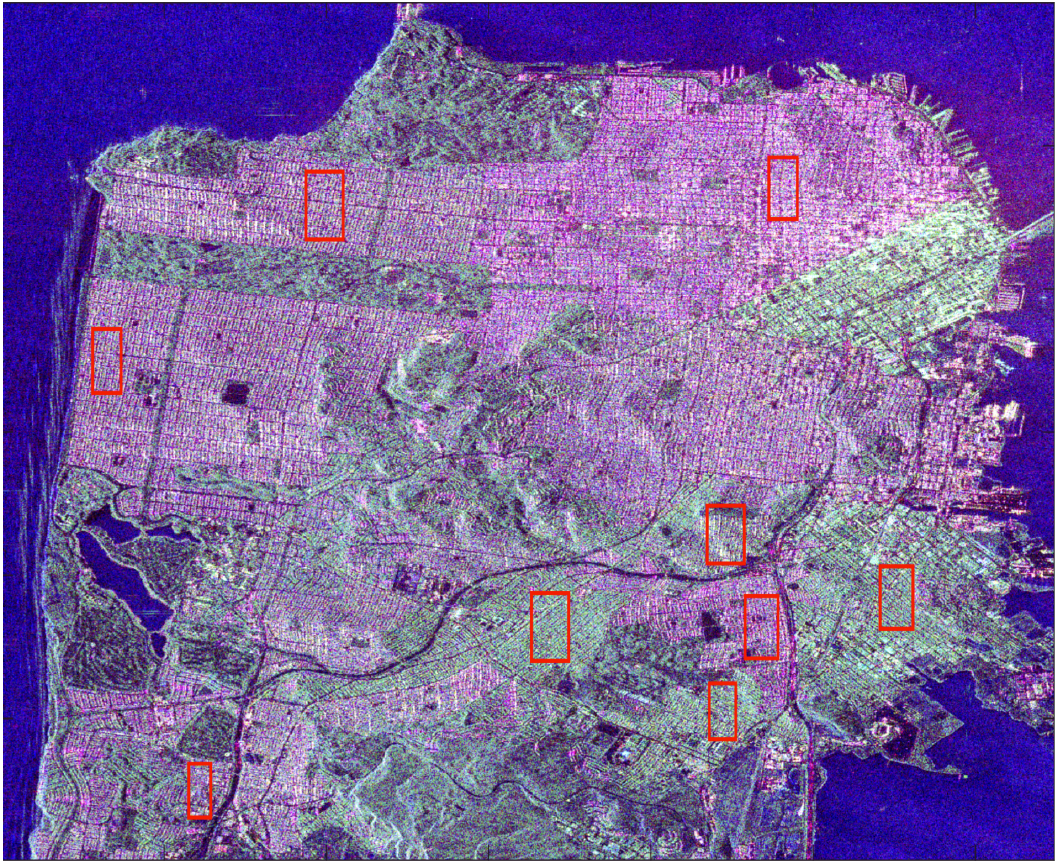
Figure 6. PolSAR image of San Francisco acquired by RADARSAT-2 (C-band) in the Pauli basis (double-bounce in red, single scattering in blue, cross-polarization in green). The sensor trajectory is parallel to the left side of the figure. Red rectangles refer to selected